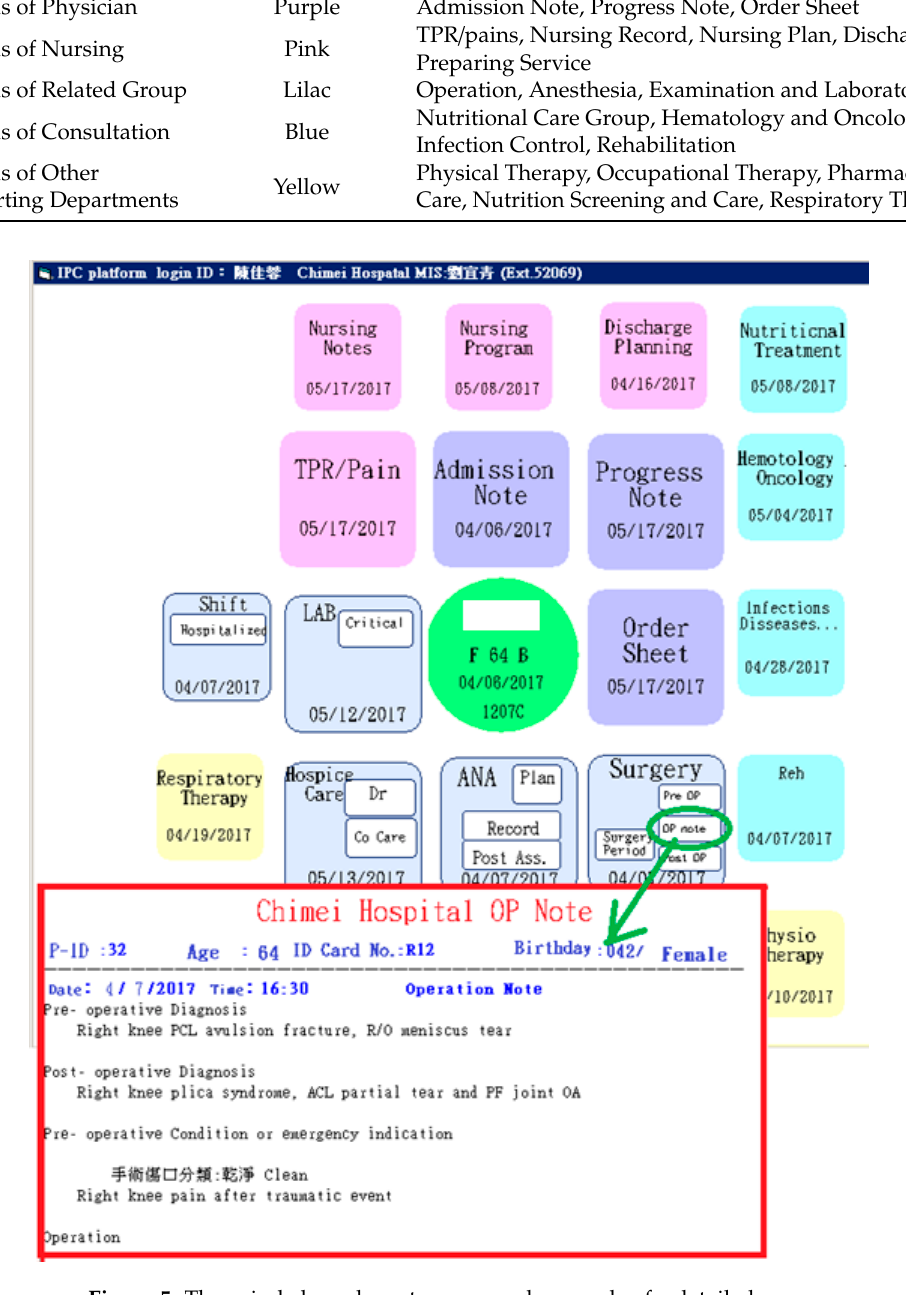
Figure 5. The spiral-shaped master page and a sample of a detailed page.